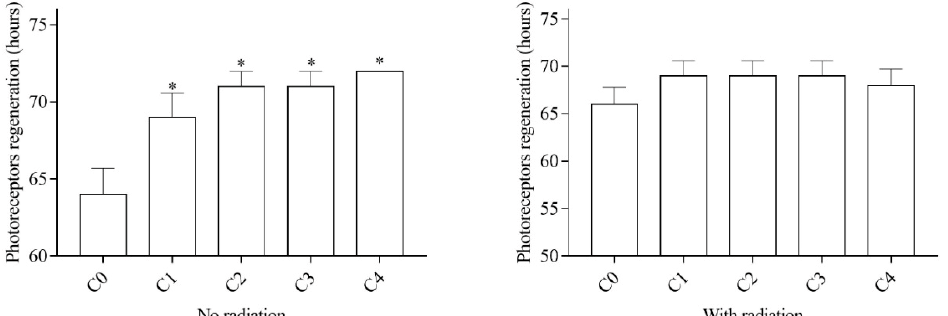
Figure 1. Chronic tests with G. tigrina : Photoreceptors regeneration (No radiation F 4,55 = 6.994, p < 0.05; With radiation F 4,55 = 0.6275, p < 0.05). * Each bar represents mean ± SD (n = 5 animals/group/replicates). Compared to the control, a significantly increased delay in the formation of photoreceptors was measured in the C1–C4 treated groups (Dunnett’s test).